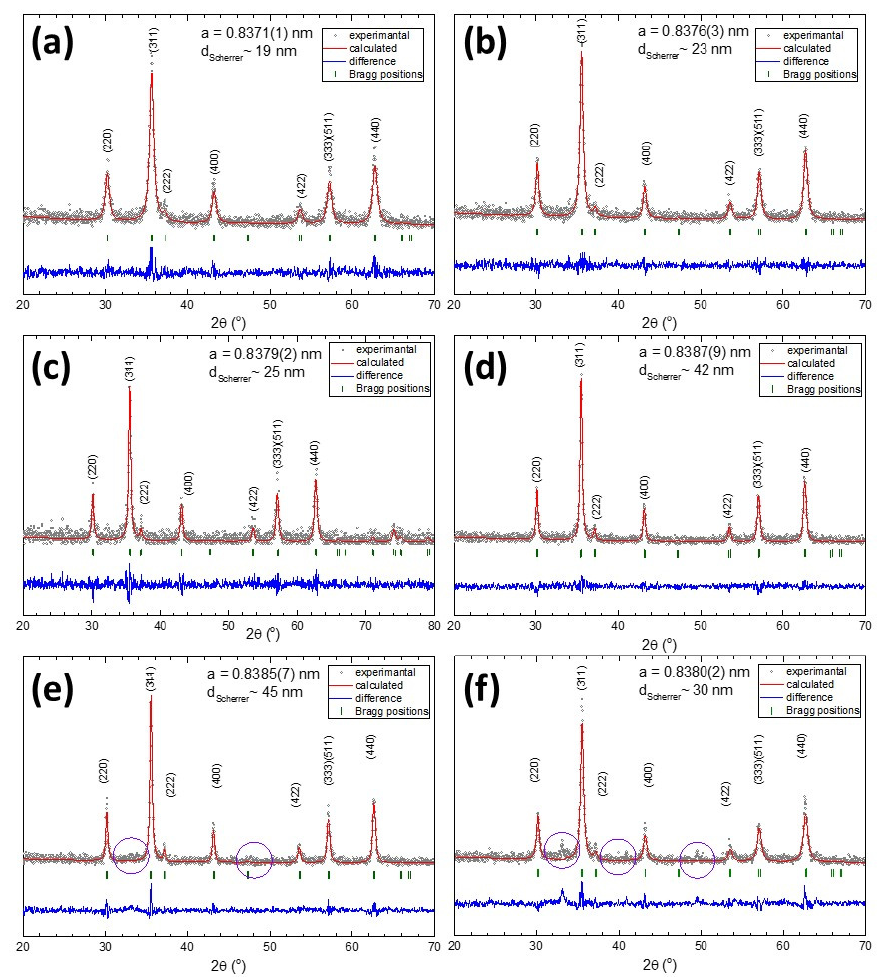
Figure 2. XRD diffractions patterns of MagNPs obtained by employing different amounts of NaAc in the synthesis: ( a ) 0.6 g, ( b ) 0.9, ( c ) 1.2 g, ( d ) 2.4 g, ( e ) 3.2 g, and ( f ) 4.8 g. The average diameters calculated based on the Scherrer equation and the lattice parameters are also indicated for each type of MagNP. The purple circles highlight the diffraction peaks probably arising from the excess of NaAc used in the reaction mixture.